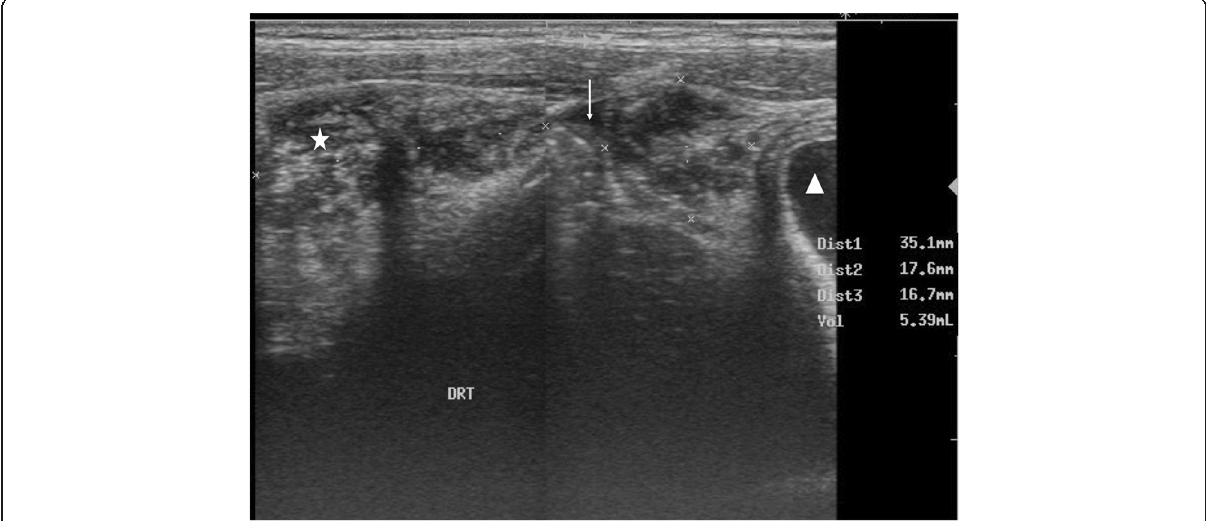
Fig. 1 Ultrasound image of a longitudinal and b transverse section of the right iliac fossa. Adjacent to the bladder (triangle) there is a heterogeneous echogenic appearance of the psoas muscle (star) due to a hematoma associated with a discrete liquid collection